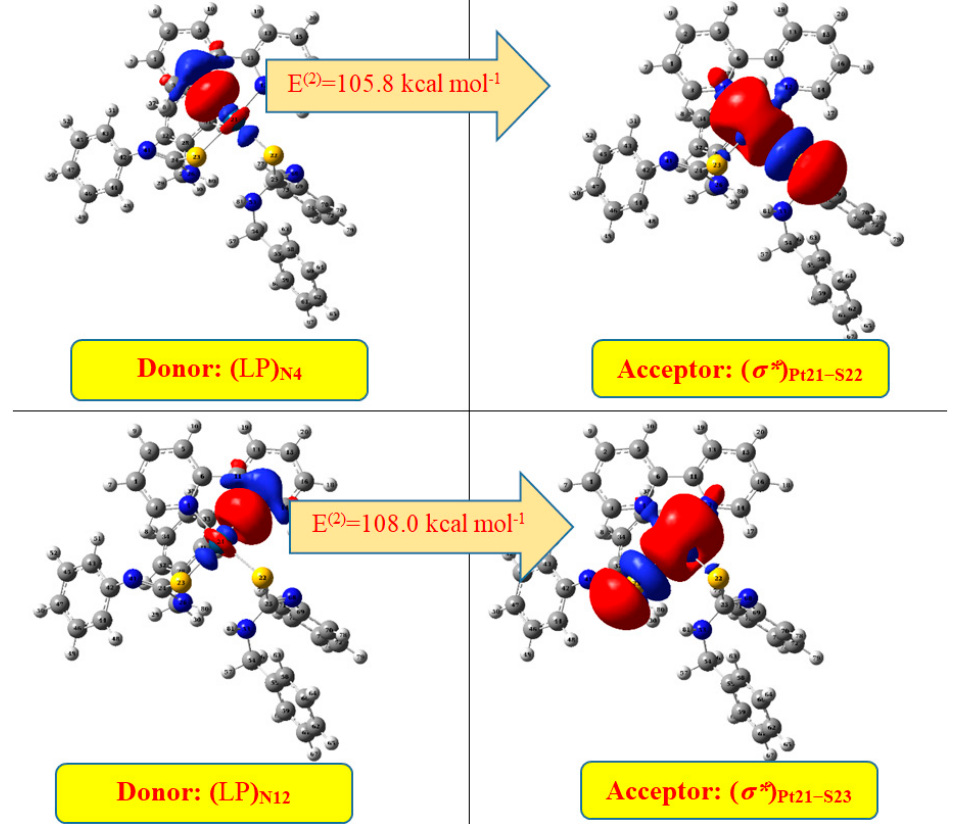
Figure 6. Donor and acceptor orbitals of two highest second-order perturbation energies (E (2) ) of [Pt(BPT)(Bipy)] ( 7 ) complex.